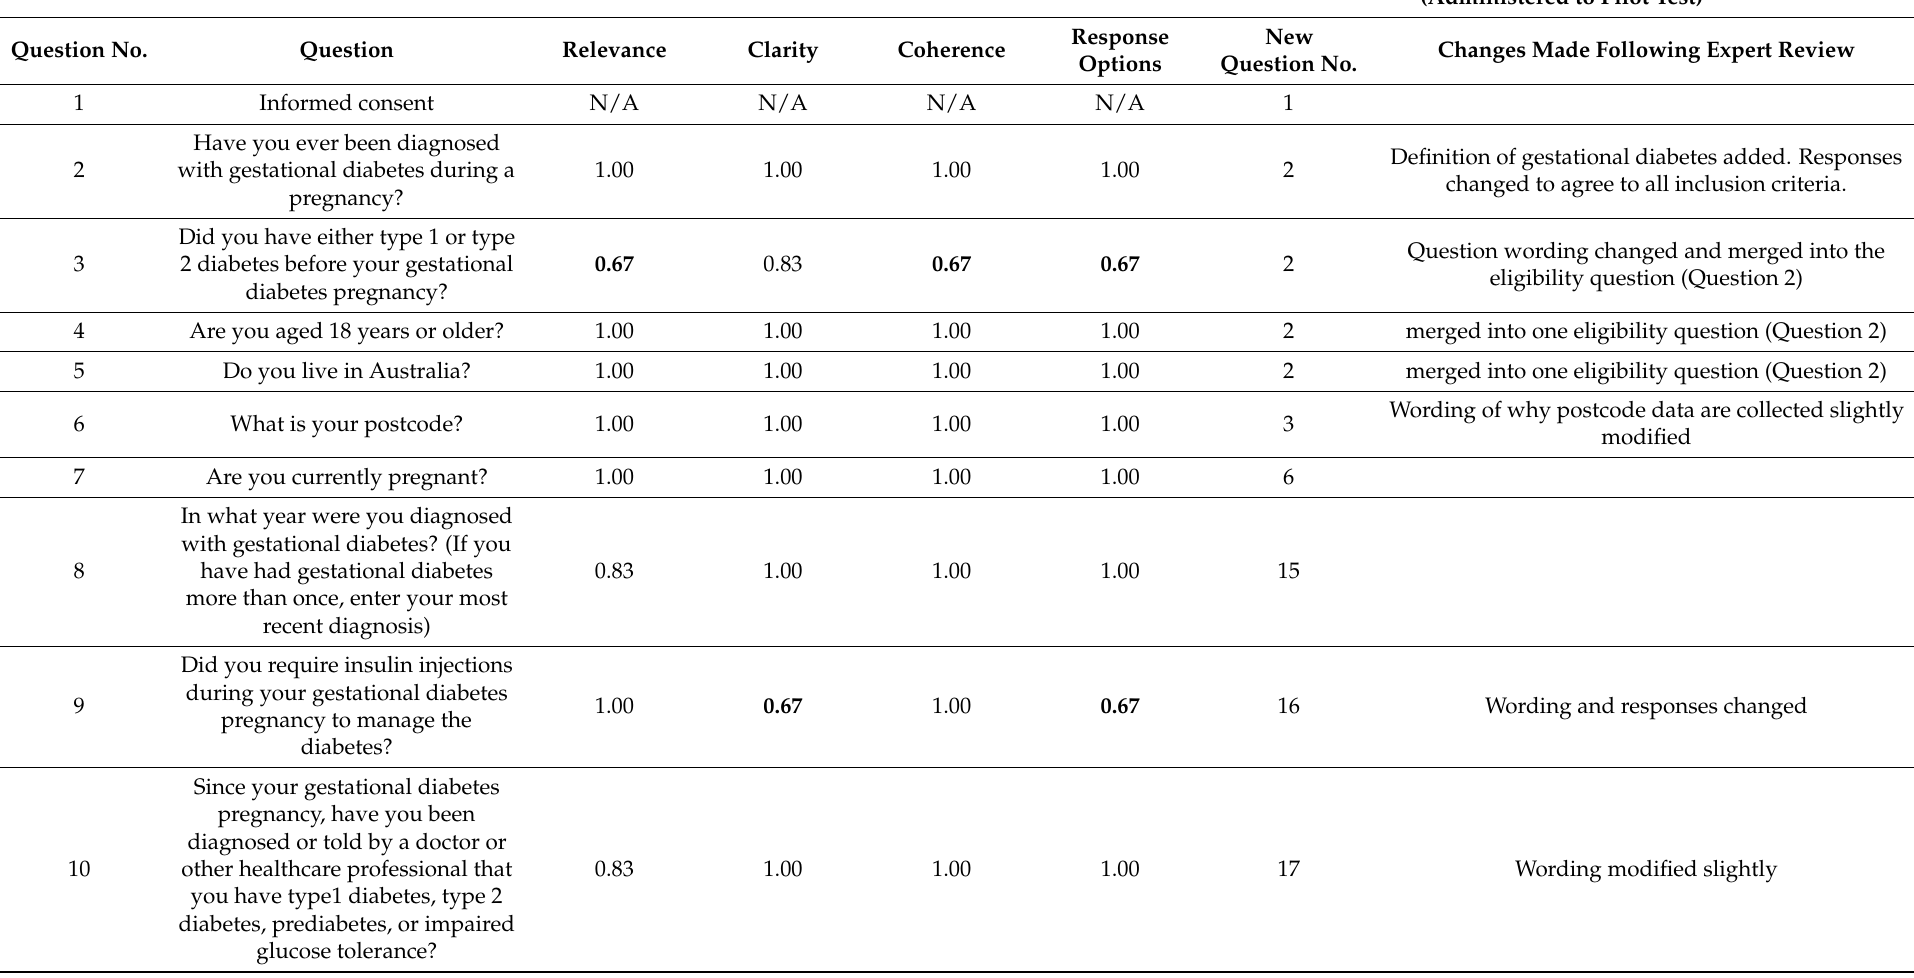
Table 1. Content validation index (I-CVI) scores from expert evaluation for each item and changes made